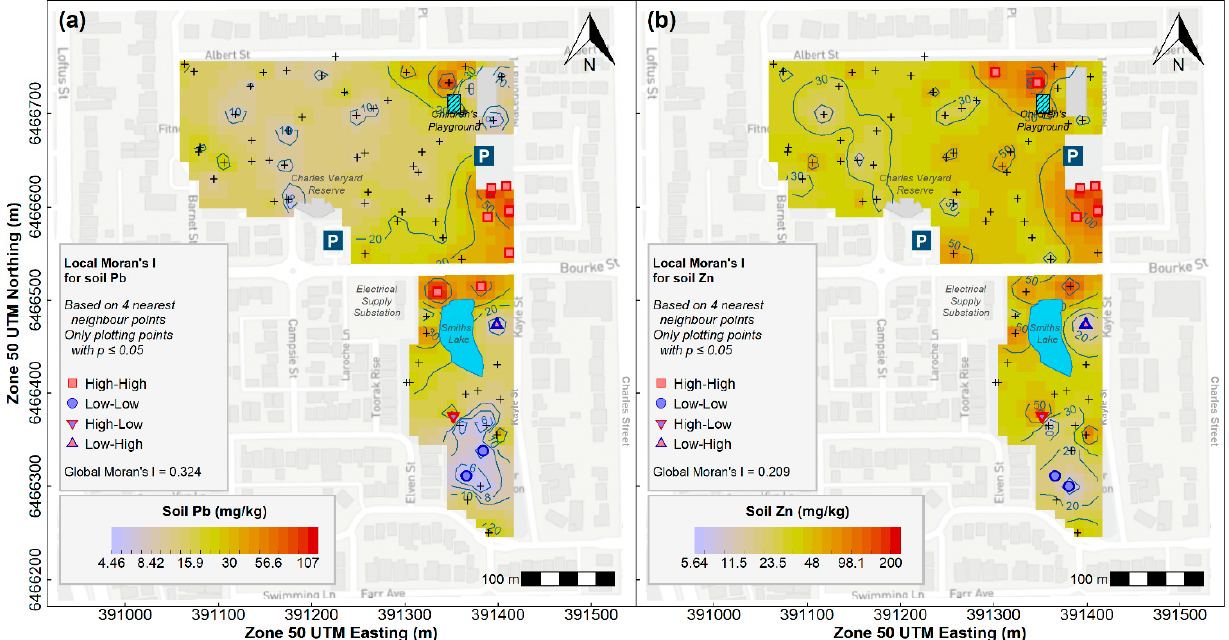
Figure 5. Spatial distributions of ( a ) Pb and ( b ) Zn in soil across Smith’s Lake and Charles Veryard Reserves, interpolated by inverse distance weighting with significant local spatial autocorrelations (Local Moran’s I ≤ 0.05) indicated with filled symbols. All sample points shown by + symbols.